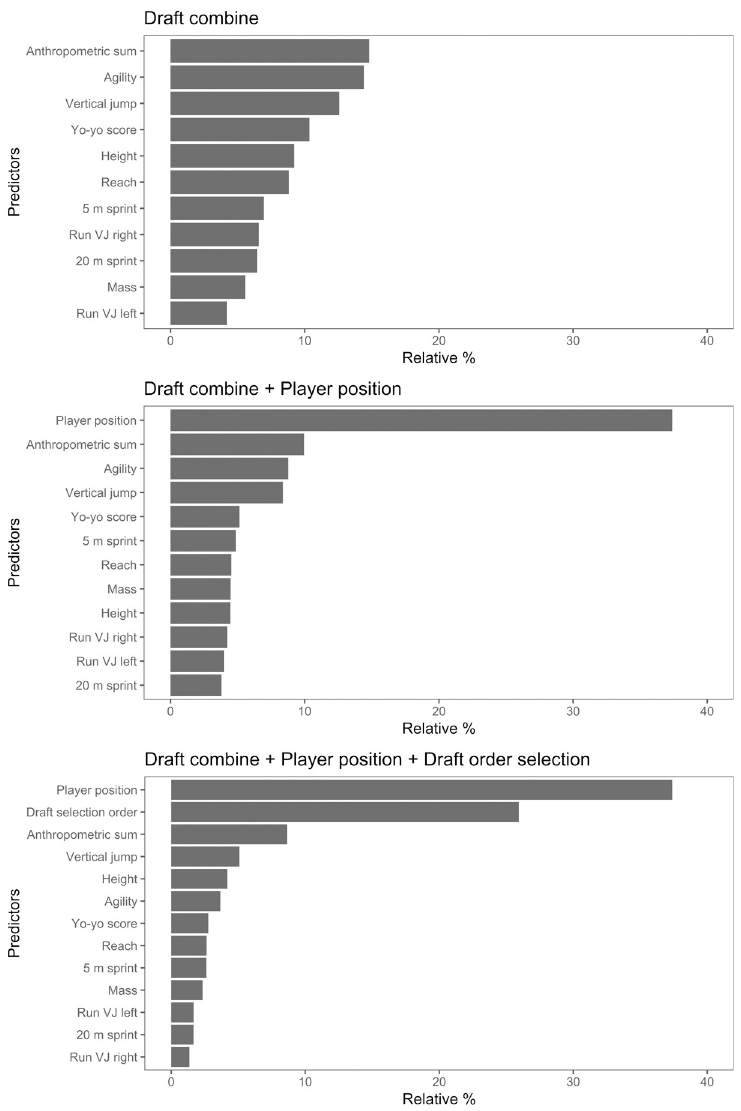
Fig 4. Relative influence of the predictor variables based on each of the boosted regression tree models. Combinations of predictor variables as follows; combine, combine + playing position, combine + playing position + draft selection